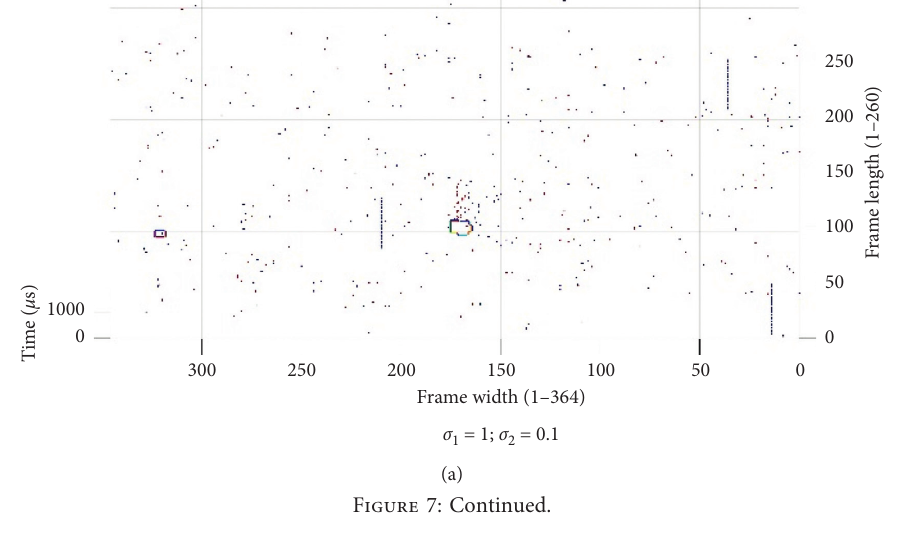
� 1; σ � 0.1. (b) σ . (a) σ 2 1 2